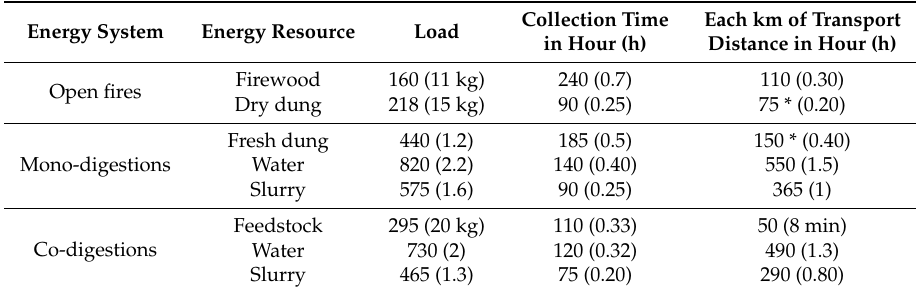
Table 3. Average time spent annually and daily on individual resource collection and transportation in different energy